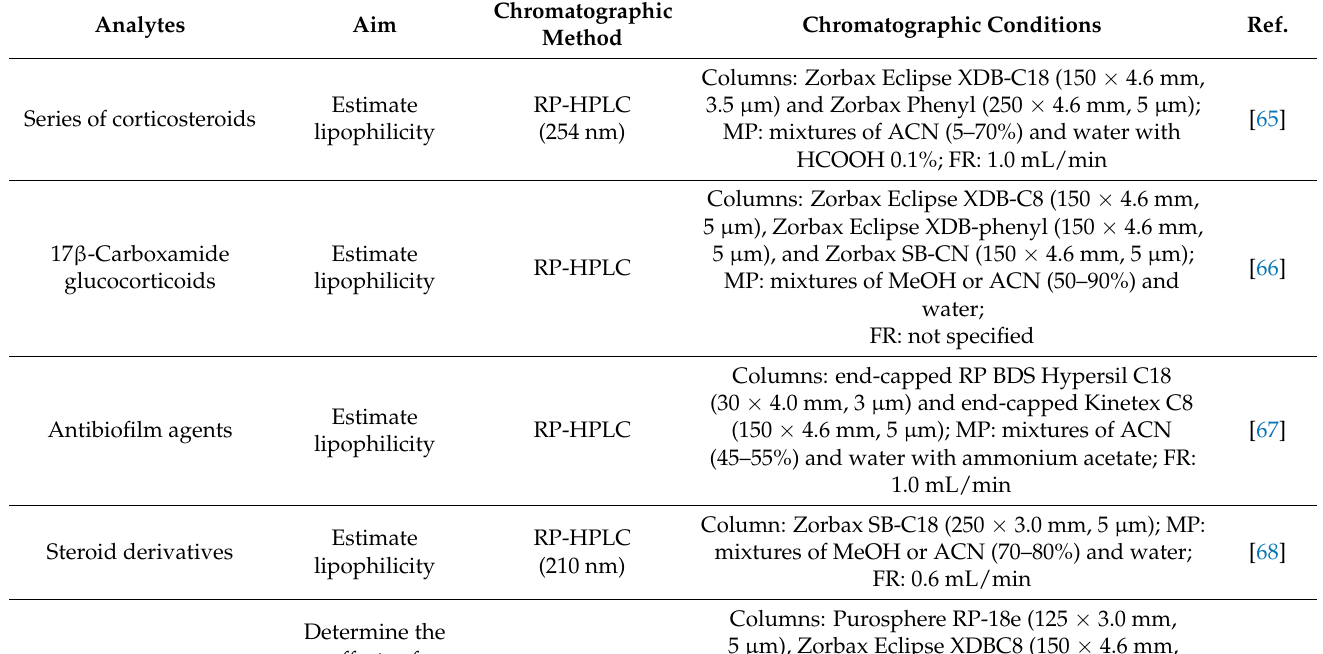
Table 1. Indirect methods for determining lipophilicity coupled with LC (full list of abbreviations is provided at the end as table